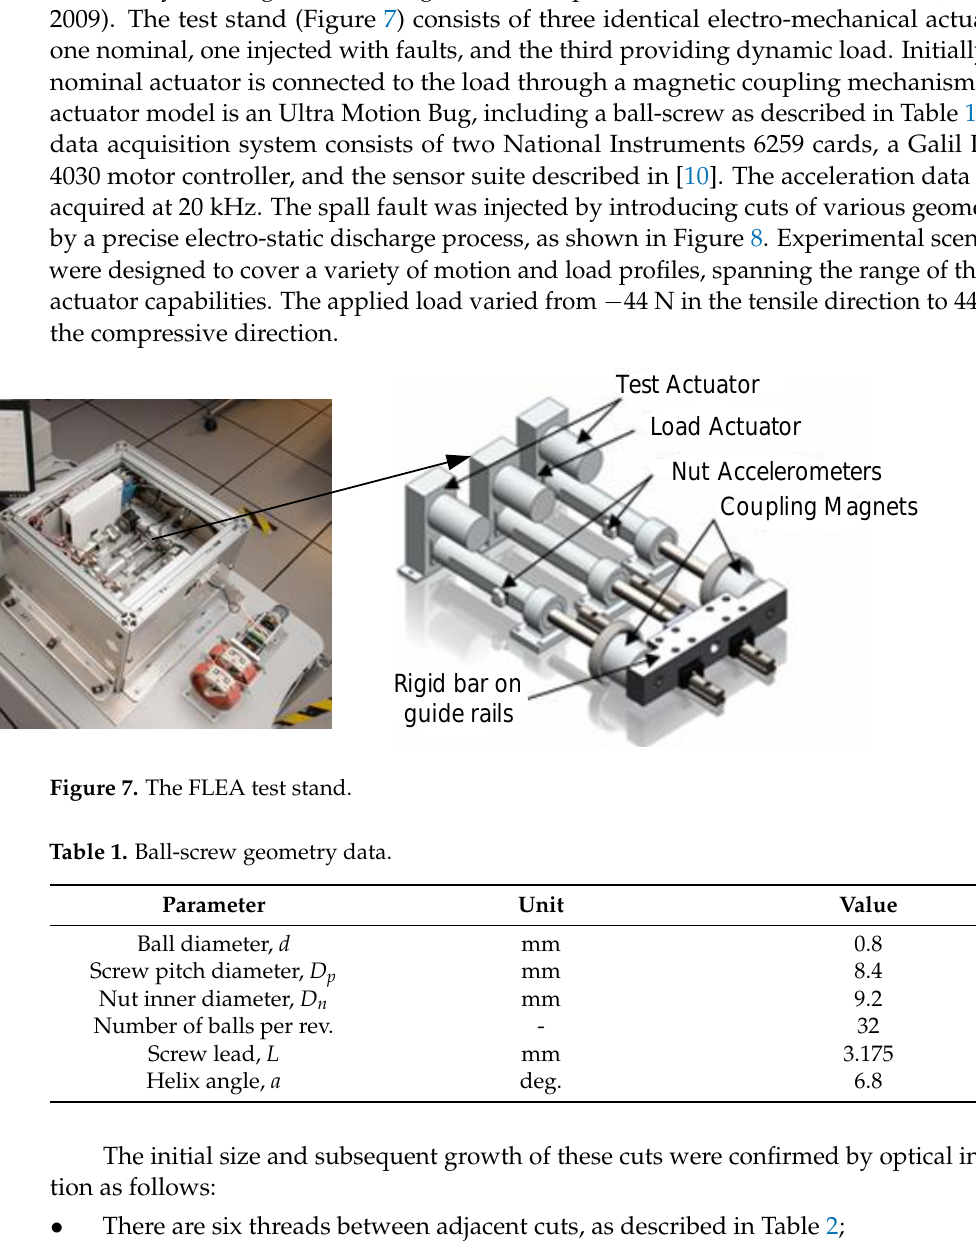
Figure 8. Spall injection on EMA’s ball-screw. Table 1. Ball-screw geometry data. Parameter